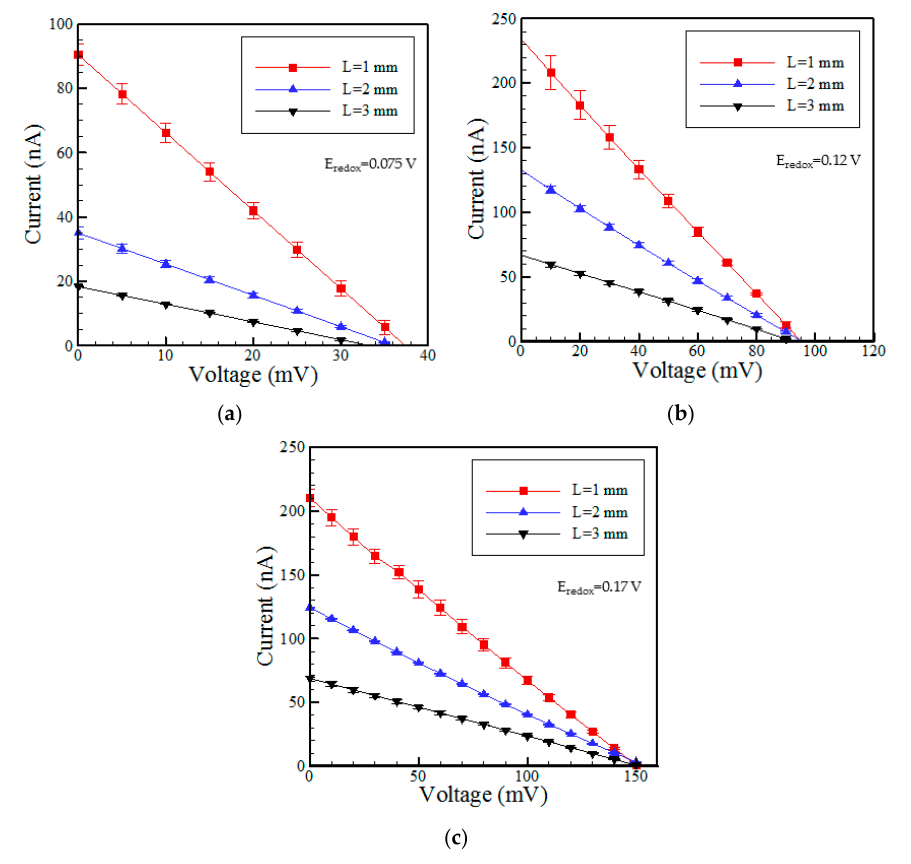
Figure 4. Current-potential curves for RED devices with different microchannel lengths and concentration ratios of: ( a ) 10:1; ( b ) 100:1; and ( c ) 1000:1 (unit is mM).